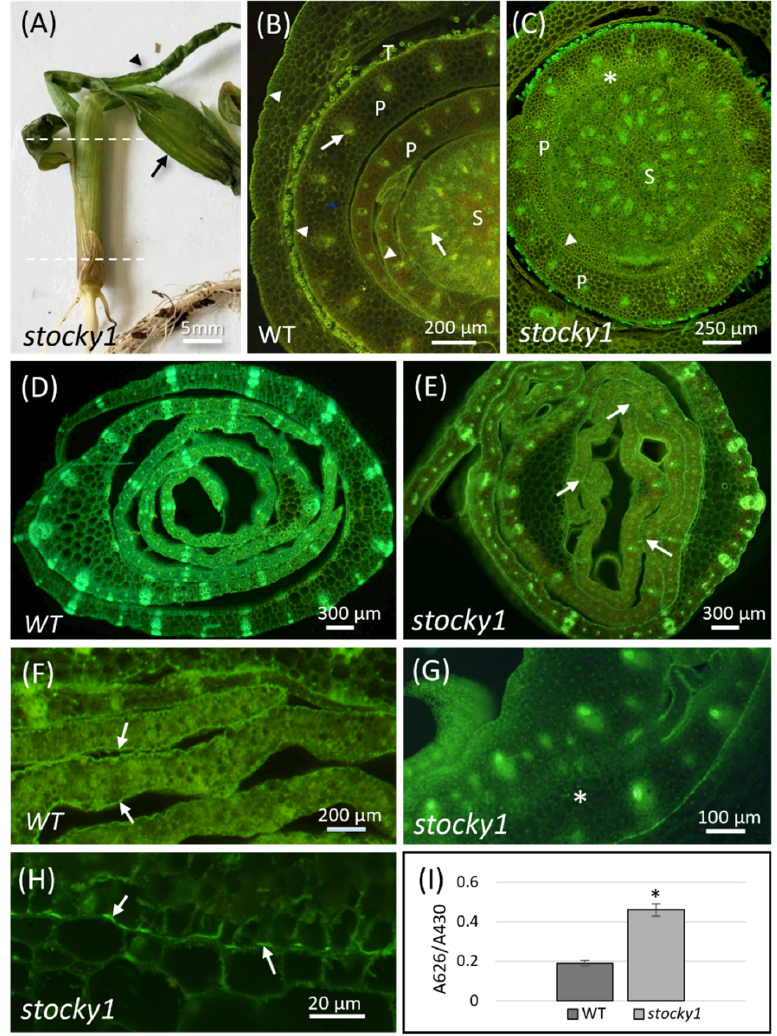
Figure 2. Phenotypic characterization of stocky1 seedlings: ( A ) Representative stocky1 seedling at 12 DAS showing the first three developing leaves; the third leaf (arrowhead) is bent, rolled and twisted, and has been released manually from the second one (arrow), which is ripped in the adhesion regions; the lower and upper dashed lines indicate, respectively, the proximal and distal part from which cross sections shown in C, E, G, H, have been cut. Cross sections shown in B, D, F, are from WT seedlings and were cut in the same regions for comparison; all sections were stained with Calcofluor White and Auramine-O, the latter specific for the cuticle, which stains in bright yellow- green when excited at about 450 nm by the fluorescence microscope. ( B ) WT proximal region showing normally developed leaf primordia [P] rolled up around the stem [S] and outlined by a bright yellow cuticle (arrowheads); leaf trichomes [T] and xylem vessels (arrows) are also visible by autofluorescence. ( C ) stocky1 proximal region with leaf primordia [P], in some parts not completely separated from each other (asterisk) and with a less defined cuticle (arrowhead); the stem [S] is larger than in WT seedlings. ( D ) Distal part of a WT seedling with rolled and well-separated developing leaves which show a continuous cuticle, more clearly visible in the enlargement in F (arrows). ( E ) Distal part of a stocky1 seedling in which developing leaves are fused together in some regions (arrows); in these regions, the cuticle of the fused leaves is not visible, as shown in the enlargement in G (asterisk); in other fused regions, the cuticle appears discontinuous ( H , arrows). ( I ) TB permeability quantification in the wild type and in the stocky1 mutant showing a higher TB uptake in the latter; error bars represent SD from three biological replicates; black asterisk indicates a statistically significant difference ( P < 0.01) obtained with t -Test.